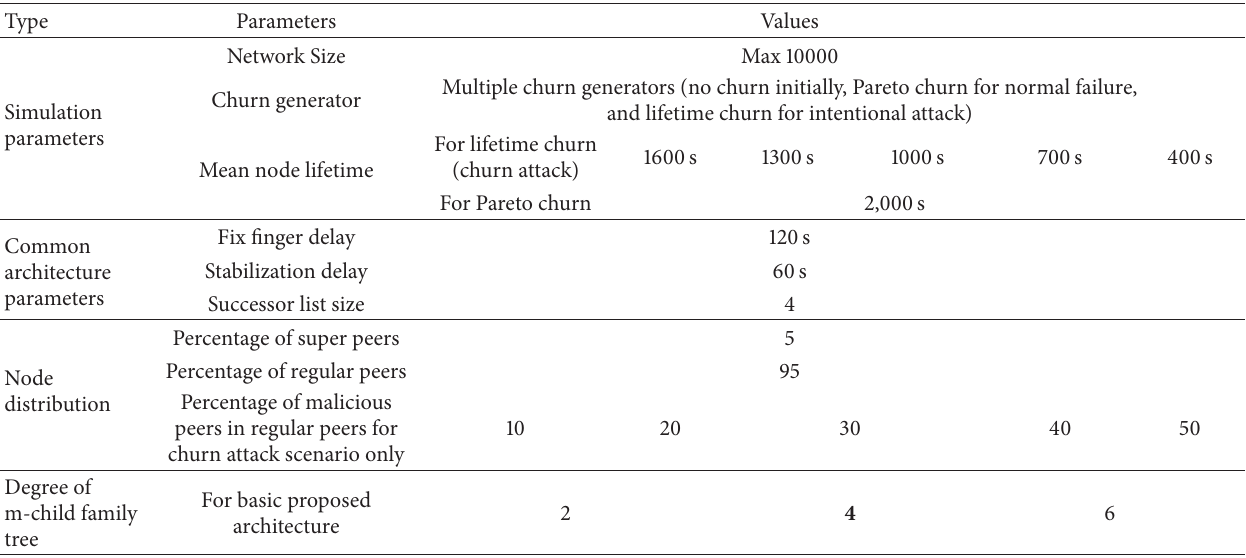
Table 2: Simulation